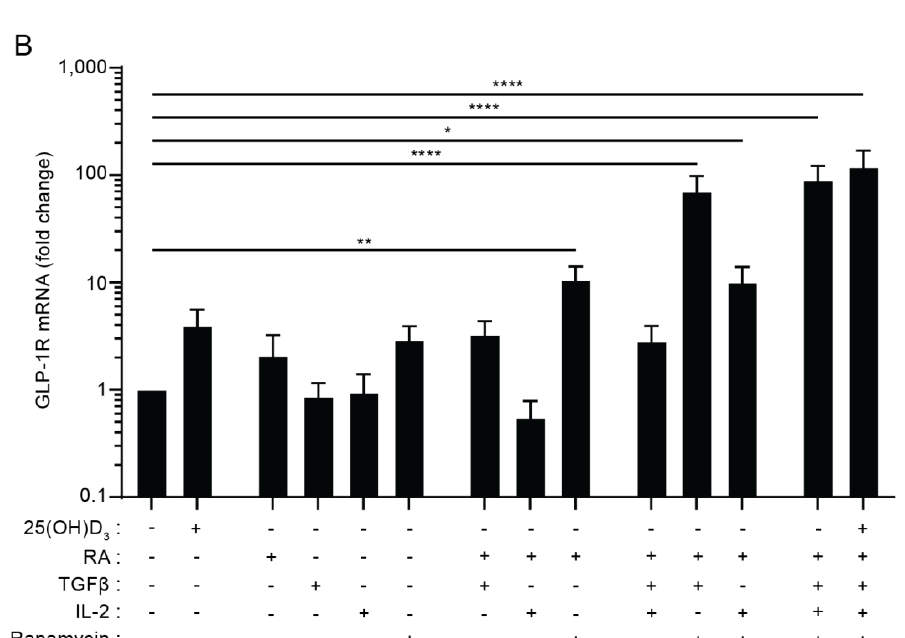
Figure 3. The combination of TGFβ, rapamycin and retinoic acid induces expression of FoxP3 and the GLP-1R in parallel in T cells. Relative FoxP3 ( A ) and GLP-1R ( B ) expression in CD4 + T cells activated for 120 h in the presence of the indicated components of the Treg polarizing medium in the absence or presence of 25(OH)D 3 (100 nM) (RA = retinoic acid, Rapa = Rapamycin). Data were normalized to FoxP3 ( A ) and GLP-1R ( B ) expression in CD4 + T cells activated in the absence of any of the components (mean + SEM, n = 4, one-way ANOVA with post-hoc test (Dunnett’s), * p < 0.05, ** p < 0.005, **** p < 0.00005. The mean of each column was compared with the mean of the first